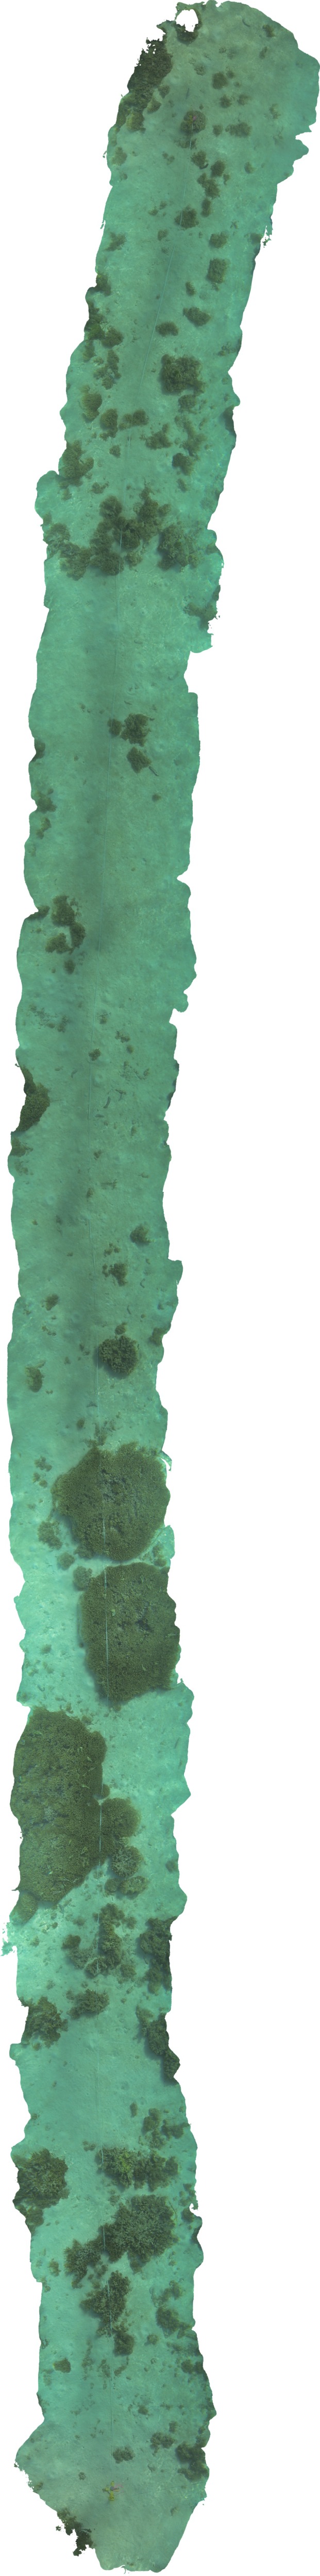
Example of transect produced using GoPro structure from motion.Here is an example of one of the transects in this study constructed using GoPro structure from motion. Note that the resolution of the source file has been greatly lowered to make it more accessible: the original file had a resolution of 60,000 × 10,000 pixels and a size of ∼50 mb.